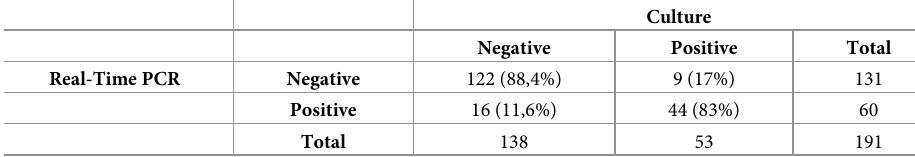
Table 3. Comparison between frequency of qPCR and culture.